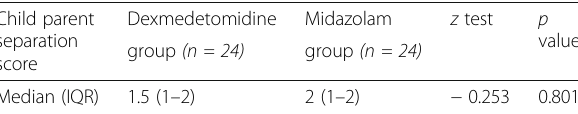
Table 9 Comparison between group D and group M as regards child parent separation score Child parent separation